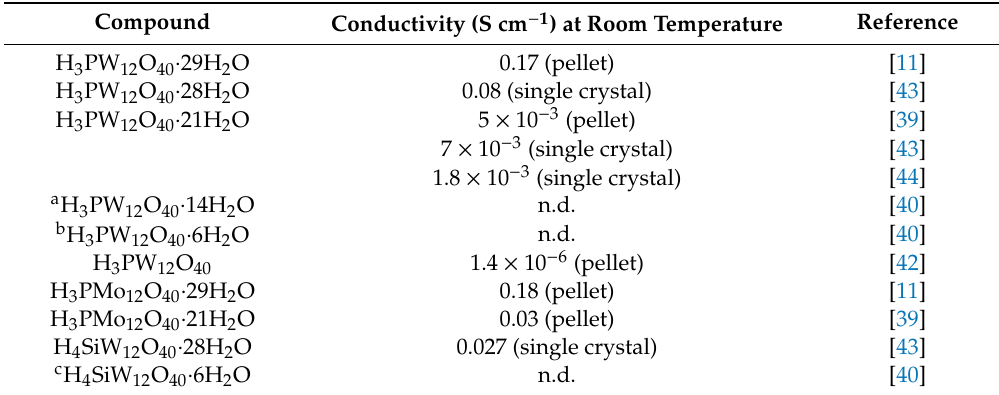
Table 1. Summary of the proton conductivity of heteropolyacids (HPAs) with di ff erent hydration levels prepared in pellet or single